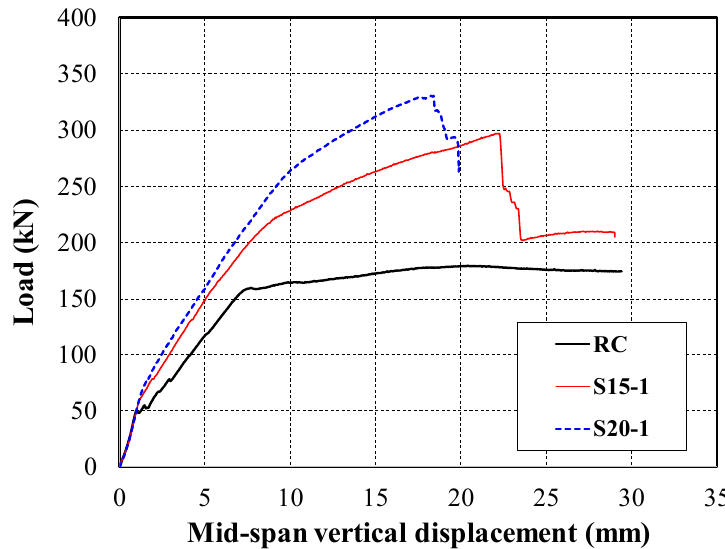
Figure 8. Comparison of load versus mid-span displacement curves of reinforced concrete (RC), S15-1, and S20-1 specimens.